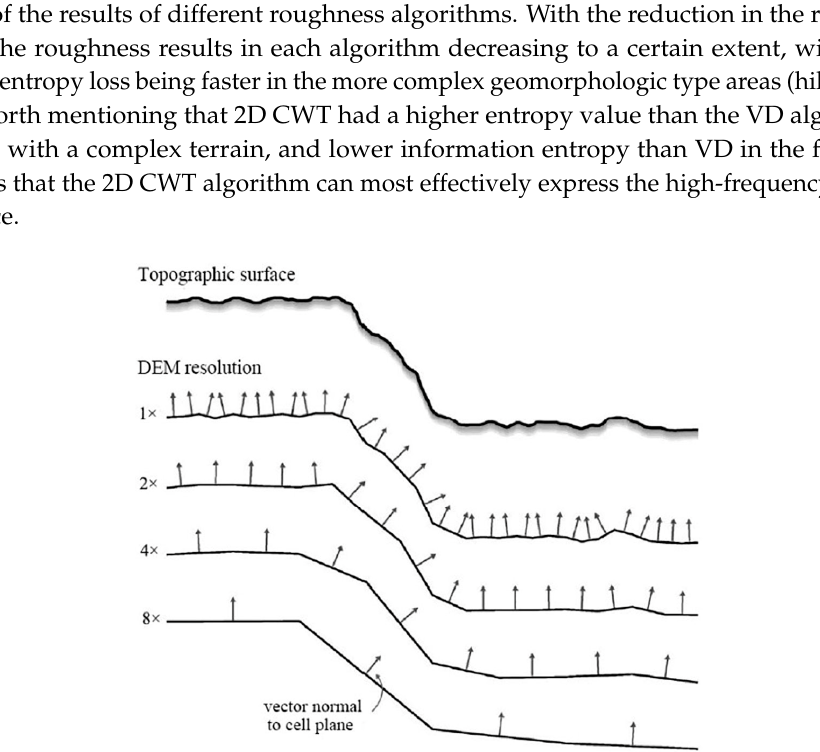
Figure 6. Schematic representation according to normal vector spatial resolution of the DEM (adapted from [11]).